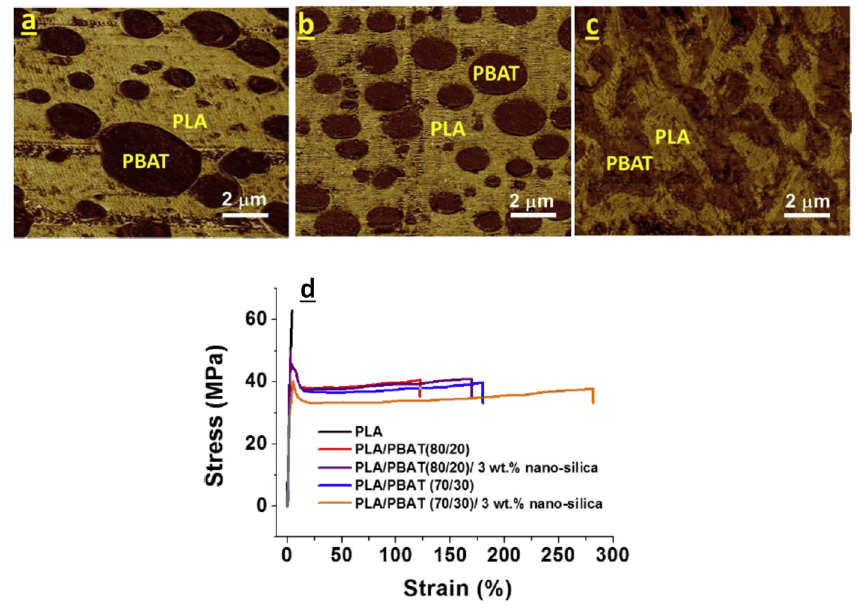
Figure 10. AFM of PLA/PBAT 70/30 ( a ); PLA/PBAT/nanosilica 70/30/1 ( b ); PLA/PBAT/nanosilica 70/30/3 ( c ); stress-strain measurements for samples with and without nanosilica ( d ) Rheological data. Reprinted (adapted) with permission from Ref. [139] Copyright 2016 Elsevier.